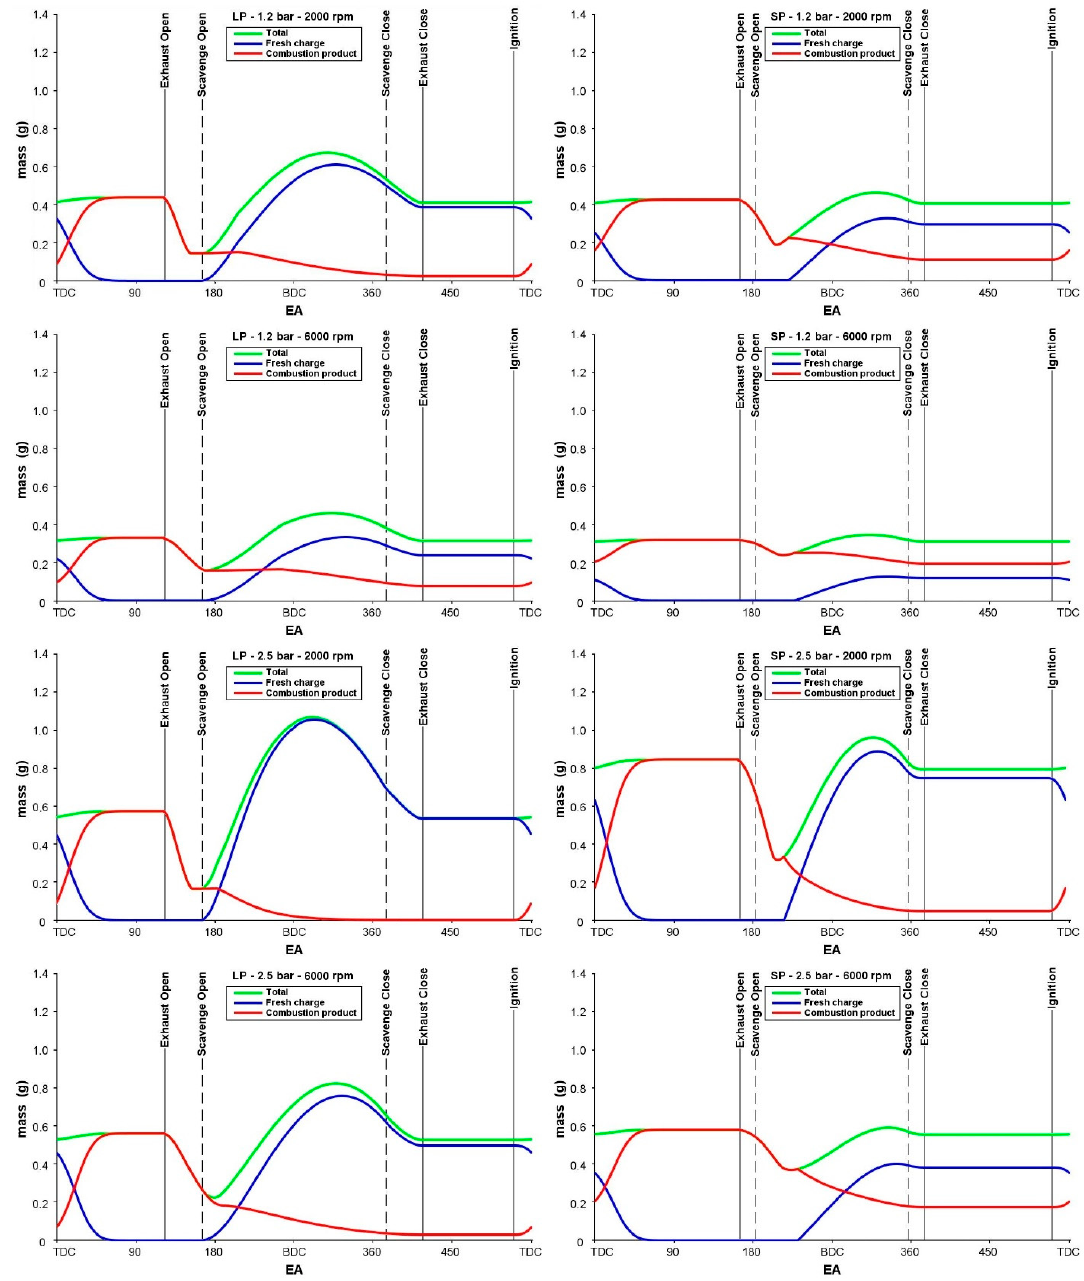
Figure 12. Change of fresh charge and combustion product mass in combustion chamber.